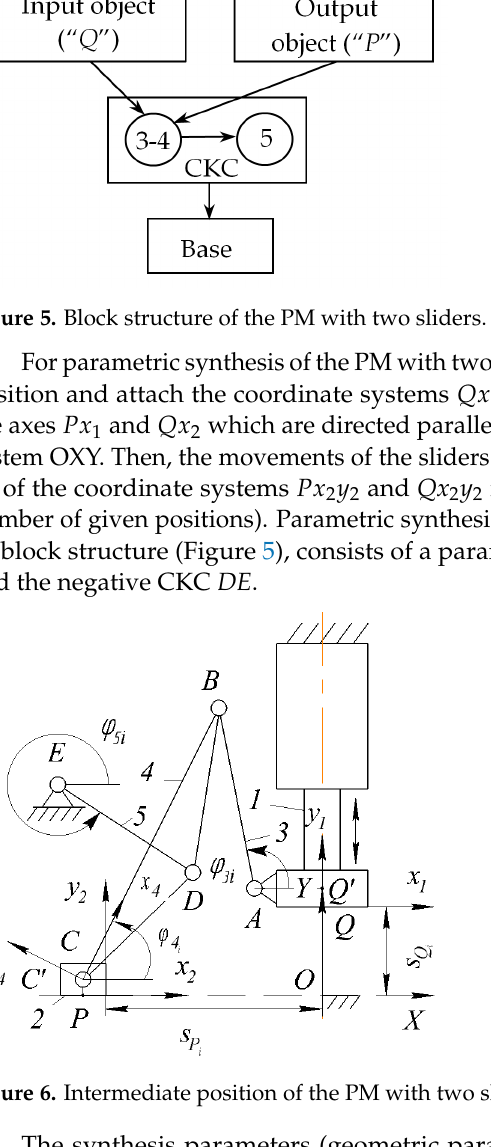
Figure 6. Intermediate position of the PM with two sliders.